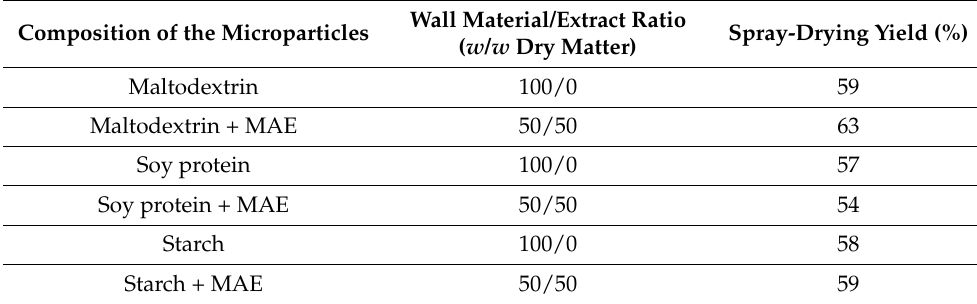
Table 2. Spray-drying yields for the different wall materials tested. Composition of the